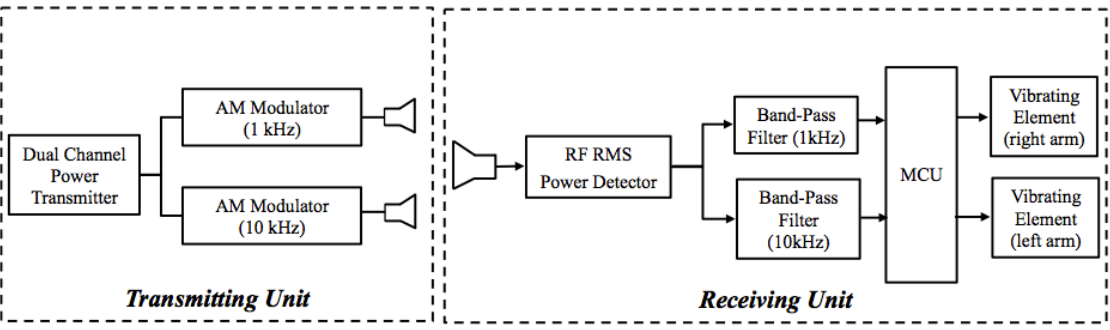
Figure 2. Schematic representation of the whole system, divided in two subunits: one transmitting unit moving in front of the user, and one receiving unit worn by the user and including two vibrational